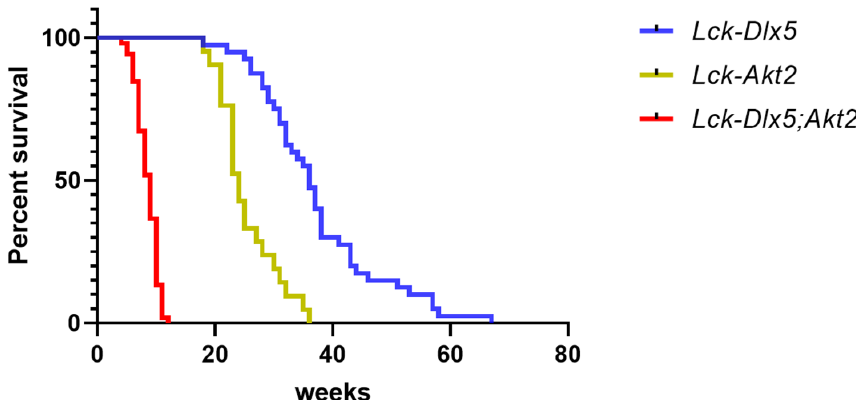
Figure 6. Survival curve of Lck - Dlx5 mice with T-cell lymphomas as compared with Lck-MyrAkt2 and double transgenic Lck-MyrAkt2; Dlx5 mice. The median survival was 24 weeks in Lck-Dlx5 mice , 39 weeks in Lck-Myr Akt2 mice , and 10 weeks in Lck-MyrAkt2;Dlx5 mice. Despite the multiple genes and pathways activated in these lymphomas, Wnt signal- ing appeared to be the key driver, because inhibition of the Wnt pathway triggered rapid cell death [67]. Whether Dlx5 can directly bind to the Ctnnb1 locus to increase its expression when the cellular context is changed by the addition of Akt hyperactivation is an intriguing question. Further study by RNA-seq analysis has demonstrated that the cholesterol biosynthesis pathway is highly upregulated in lymphoma cells from Lck-MyrAkt2;Dlx5 mice. The β -catenin/Tcf complex directly binds to genes encoding key members of this pathway, such as Cyp51 , Hmgcr , Ncoa2 , Pmvk , Sp1 , Srebf1 , Srebf2 , Tbl1x , and Tbl1xr1 . Moreover, statin and other cholesterol inhibitors were shown to effectively limit the proliferation of lymphoma cells from Lck-MyrAkt2;Dlx5 mice at low concentrations and cause cell death at higher concentrations [67] (Figure 7).